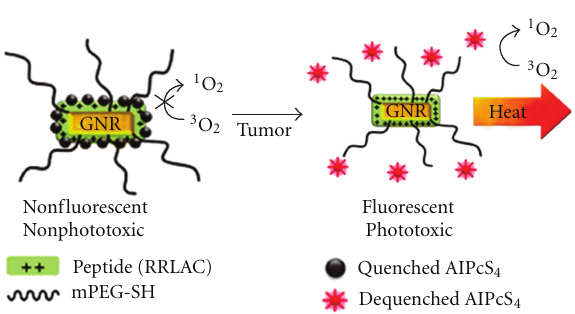
Figure 12: Polymeric carrier for thermo- and photodynamic ther- apy